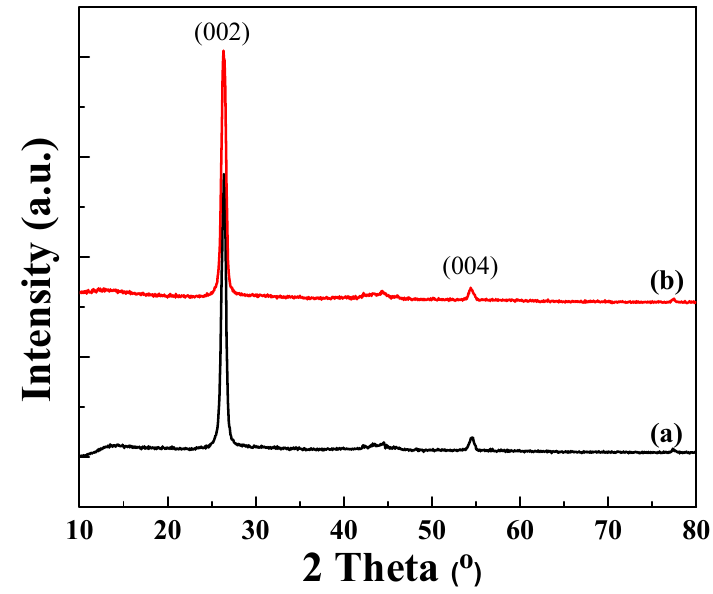
Figure 5. XRD patterns of ( a ) GN-13 ( b ) GN-28 samples.